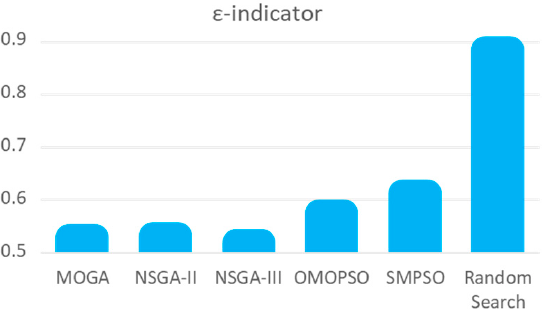
Figure 13. Average ε -Indicator of each algorithm.